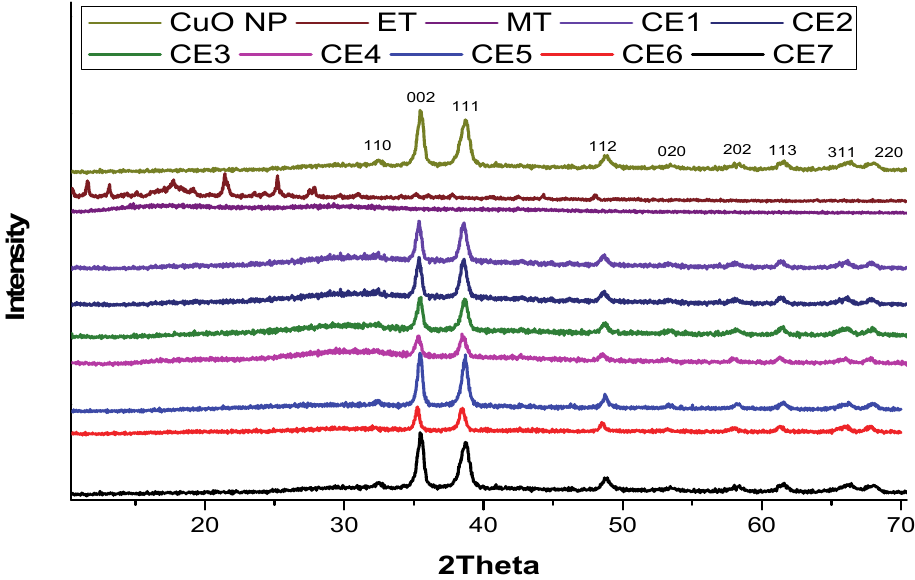
Figure 2. FT-IR spectrum of CuO NPs, ET, MT, and synthesized nanomaterials.